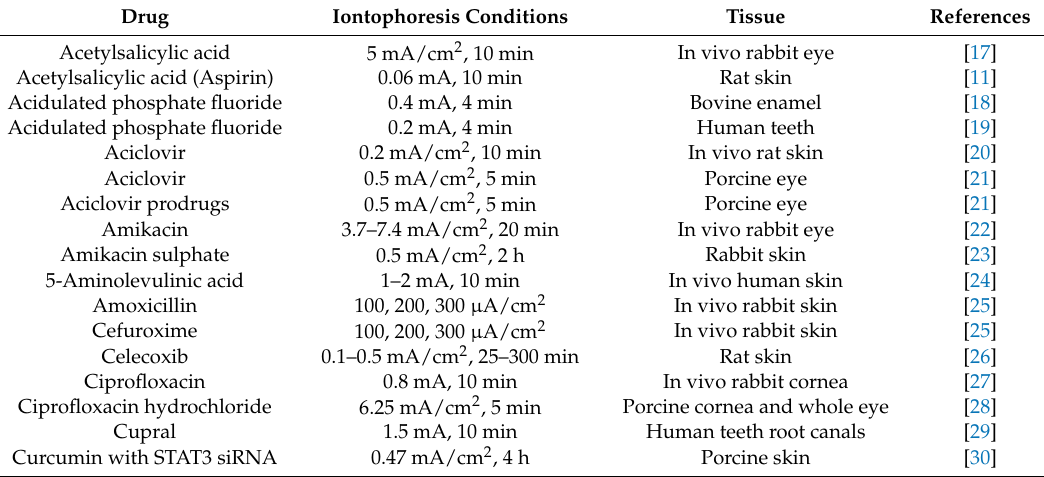
Table 1. Summary of selected studies concerning iontophoretic application of drugs. Drug Iontophoresis Conditions